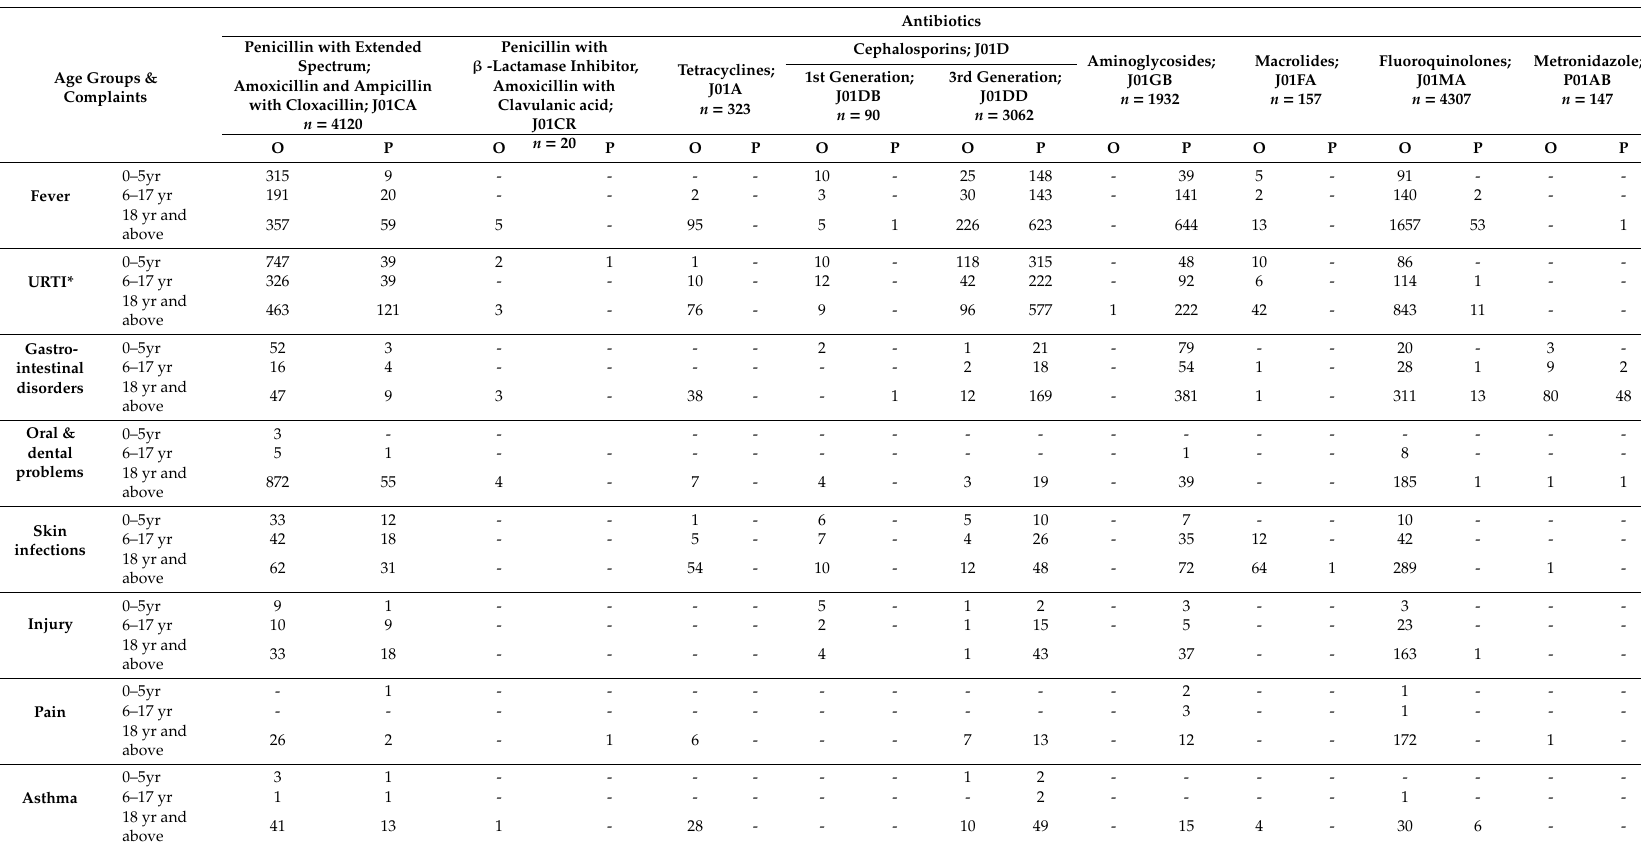
Table 3. Number of prescriptions by Anatomical Therapeutic Chemical classification antibiotic category / route of administration (O-Oral / P-Parenteral) and complaints / age group in rural Ujjain, India.